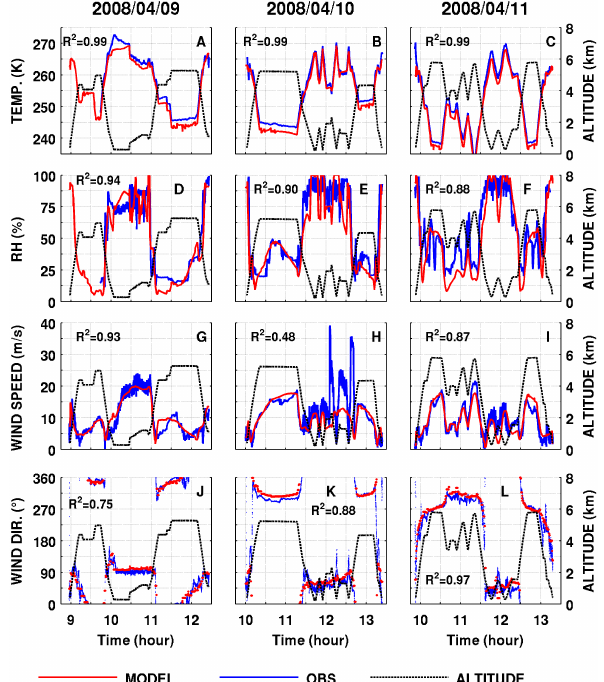
Figure 5. Time series of modeled (red) and measured (blue) (a – c) temperature, (d – f) relative humidity, (g – i) wind speed, and (j – l) wind direction extracted along the POLARCAT-France flight tracks. The corresponding aircraft altitude is shown in